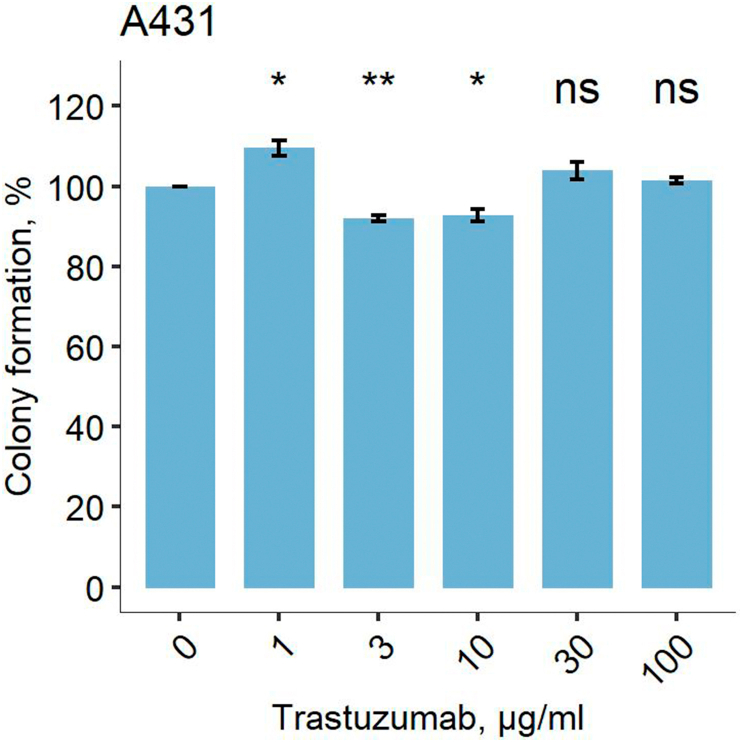
Colony formation by A431 cells in the presence of trastuzumab compared with the no-drug mode. Colony formation is given as a percentage of the number of colonies formed in the no-drug mode. The data are shown as the mean of three independent replicates ± standard deviation.